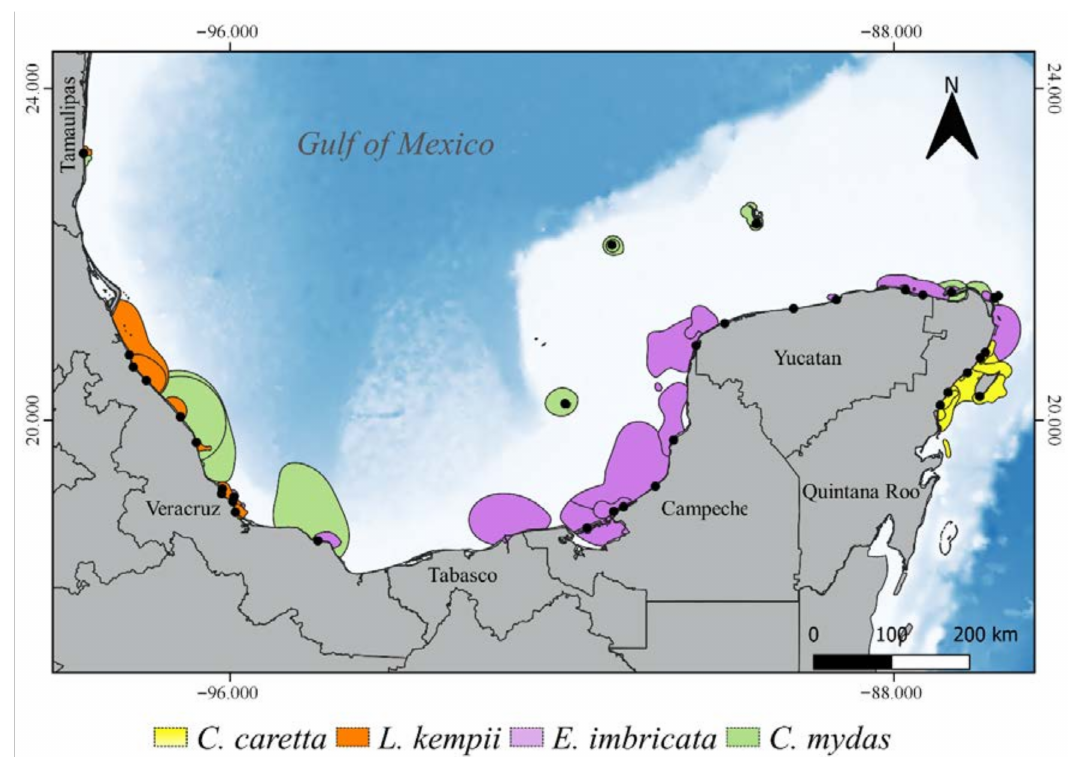
Figure 2. Internesting areas delimited for post-nesting sea turtle individuals of four species satellite-tracked from their nesting beaches (black dots, [4]) in the Gulf of Mexico and West